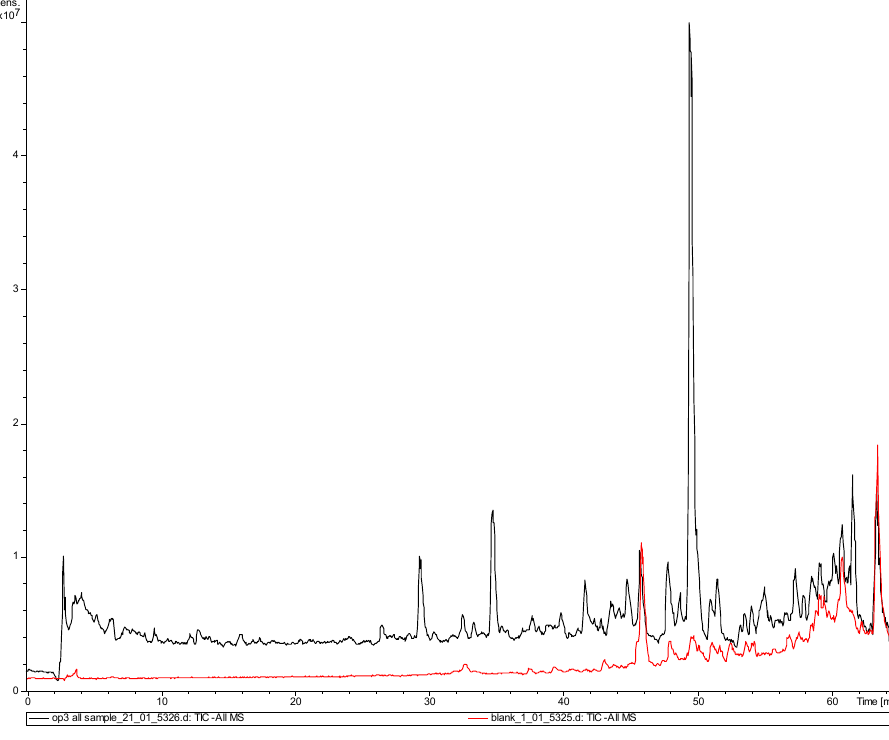
Fig. 1. Total ion chromatograms for LC-MS analysis in negative ionisation mode. Black: OP3_all extract from filters collected at the Bukit Atur, Borneo, site. Red: blank control sample. Many of the peaks after 45minutes are contaminants from the methanol used in the LC